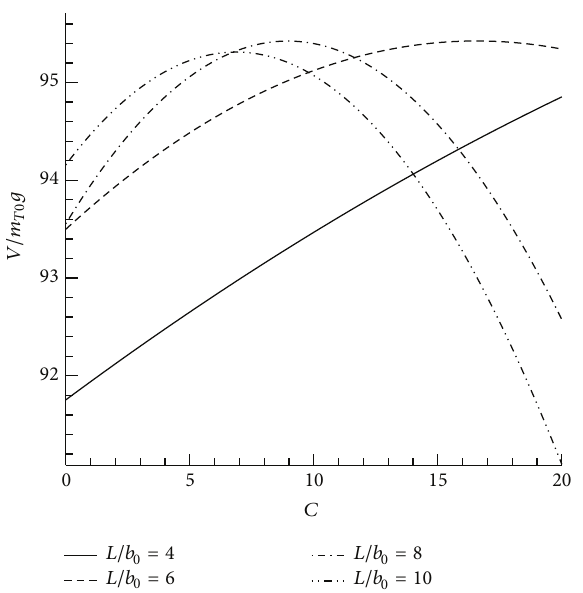
Figure 10: Tapering and length effects on unimorph, with tip mass.